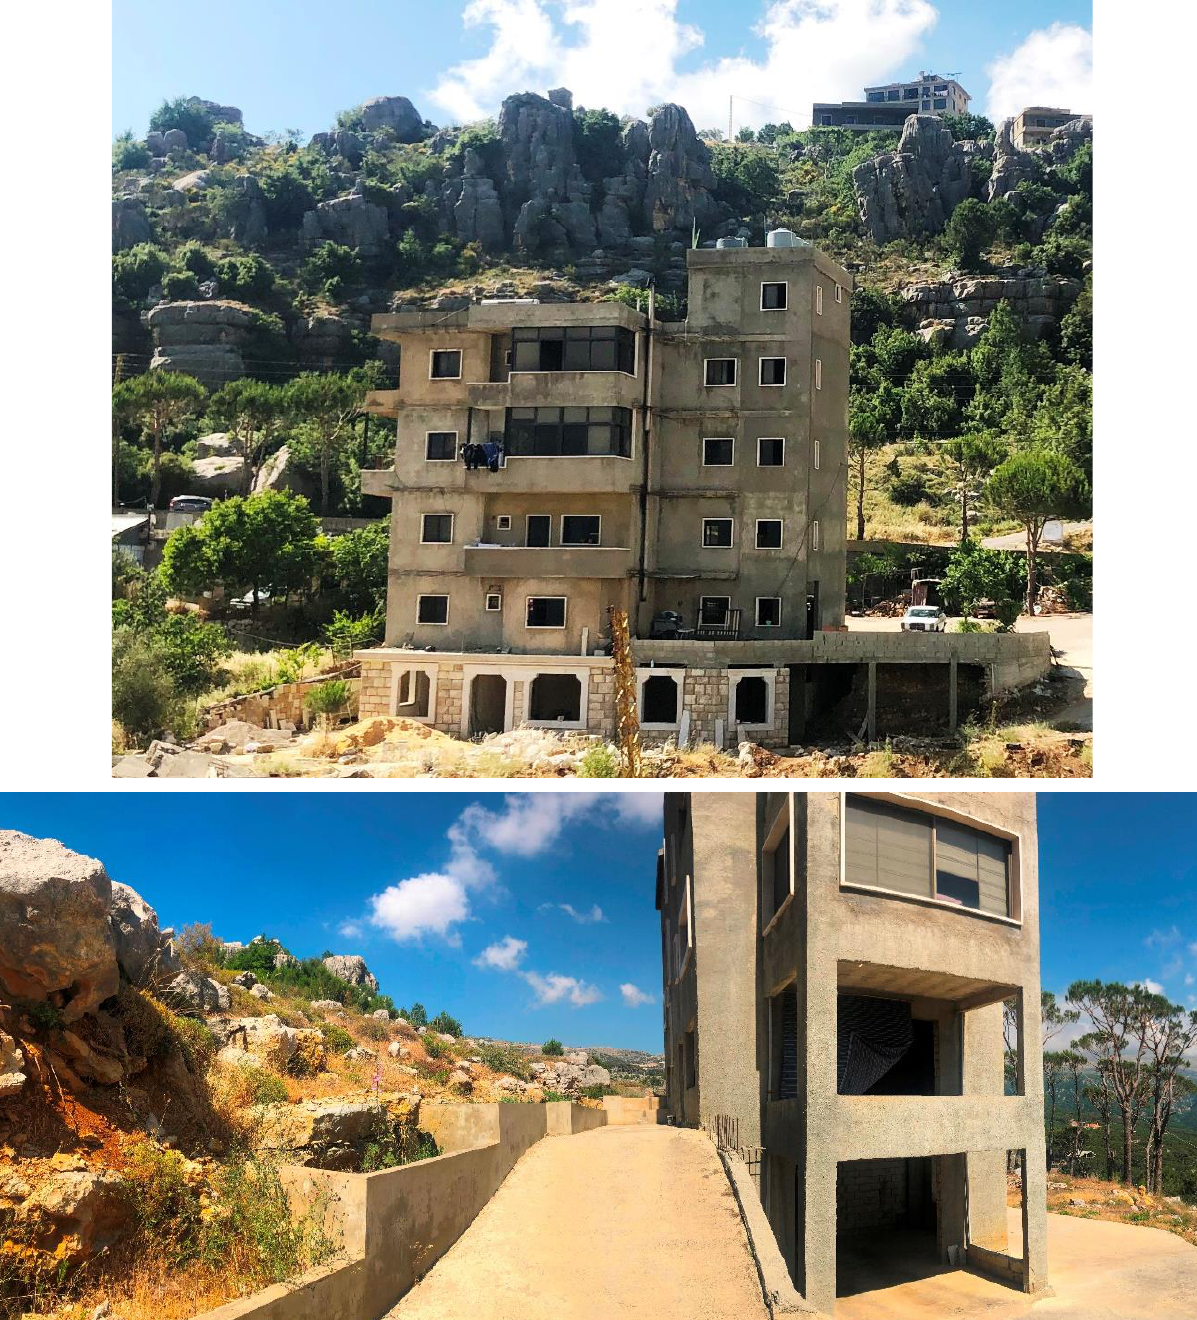
Figure 4. Massive rock boulders standing just above the buildings and the release area is just